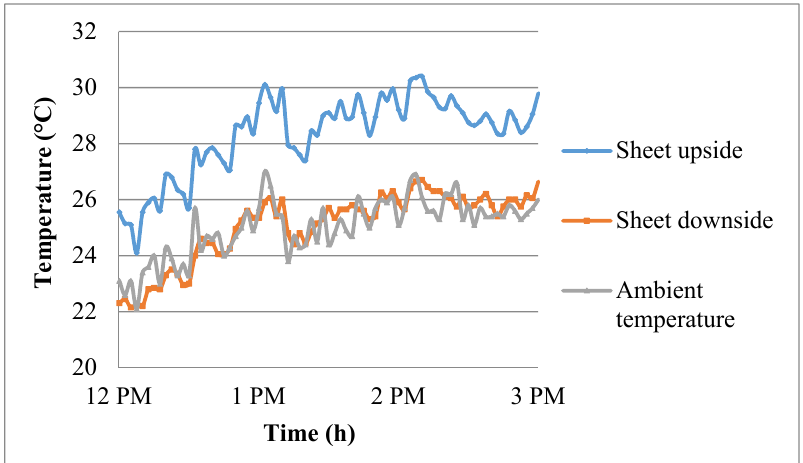
Figure 8. Time dependence of roof sheet temperature and ambient temperature for model cowshed with installation of monocrystalline PV module.